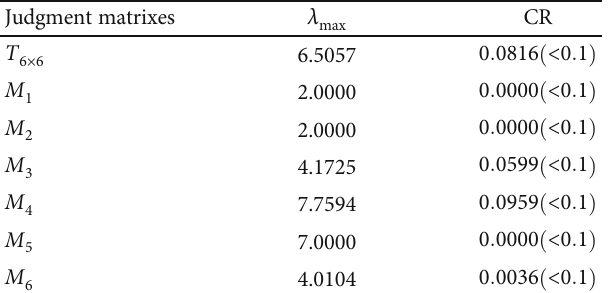
M fi ed a and criteria b (modi